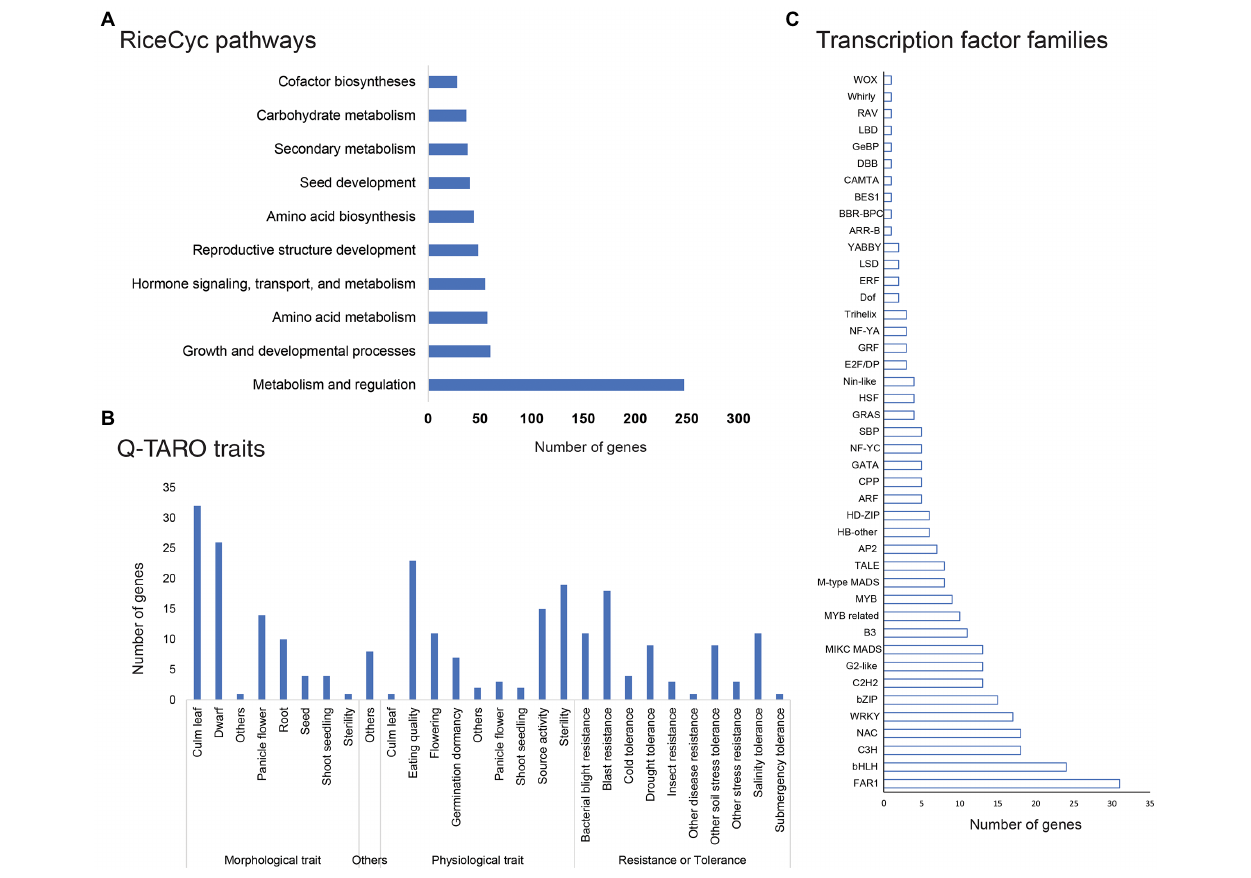
FIGURE 7 | Pathway, trait and regulatory gene families affected by SNP or InDels; (A) Pathway analysis of common genes affected by genetic variations in all mutant lines; (B) common genes affected by genetic variations involved in major traits in rice; and (C) Common genes affected by SNP or InDel variations belonging to major rice transcription factor families (taken from